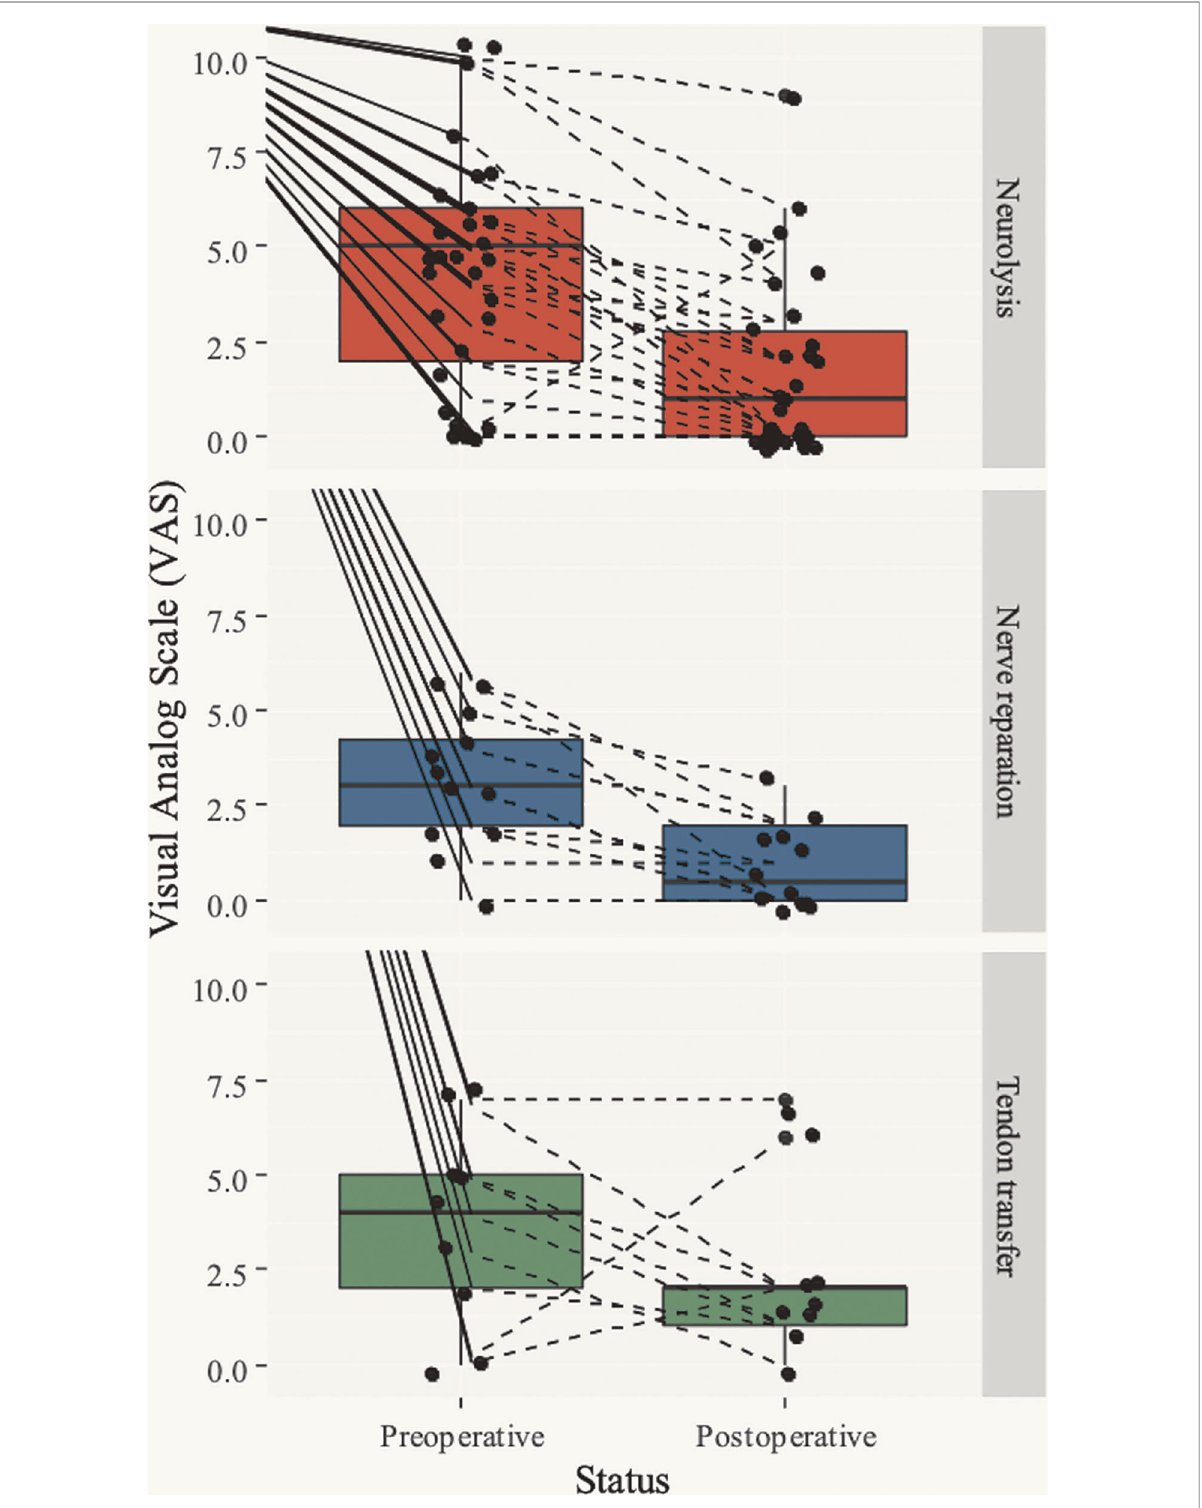
FIGURE 2 VAS pain scale difference between preoperative and postoperative status by class of surgery. VAS, visual-analog scale.